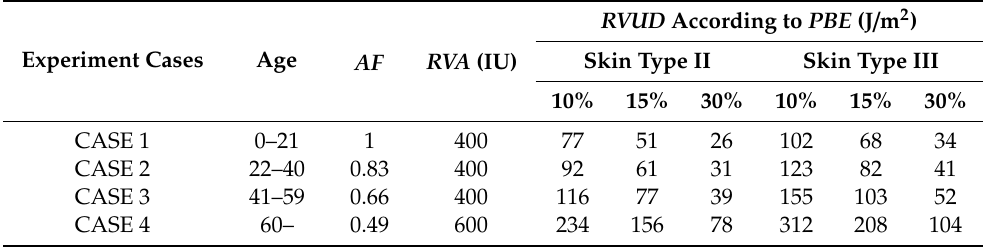
Table 2. Age-specific Recommended Vitamin D UV Dose ( RVUD , skin types 2 or 3) according to the exposure area of the user.